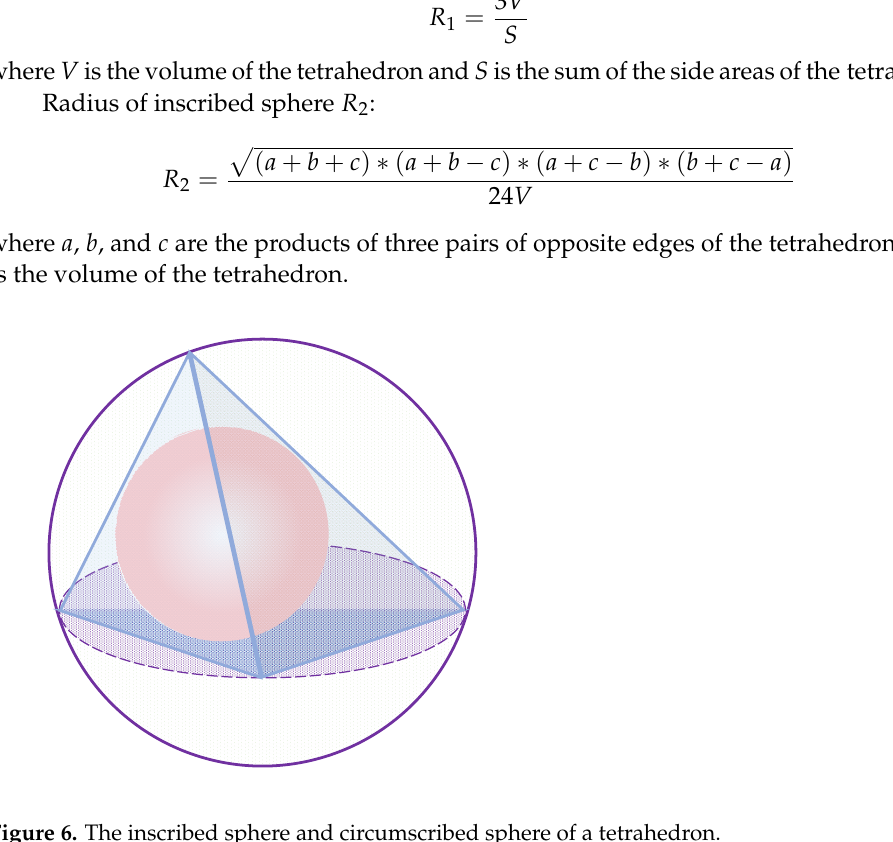
Figure 6. The inscribed sphere and circumscribed sphere of a